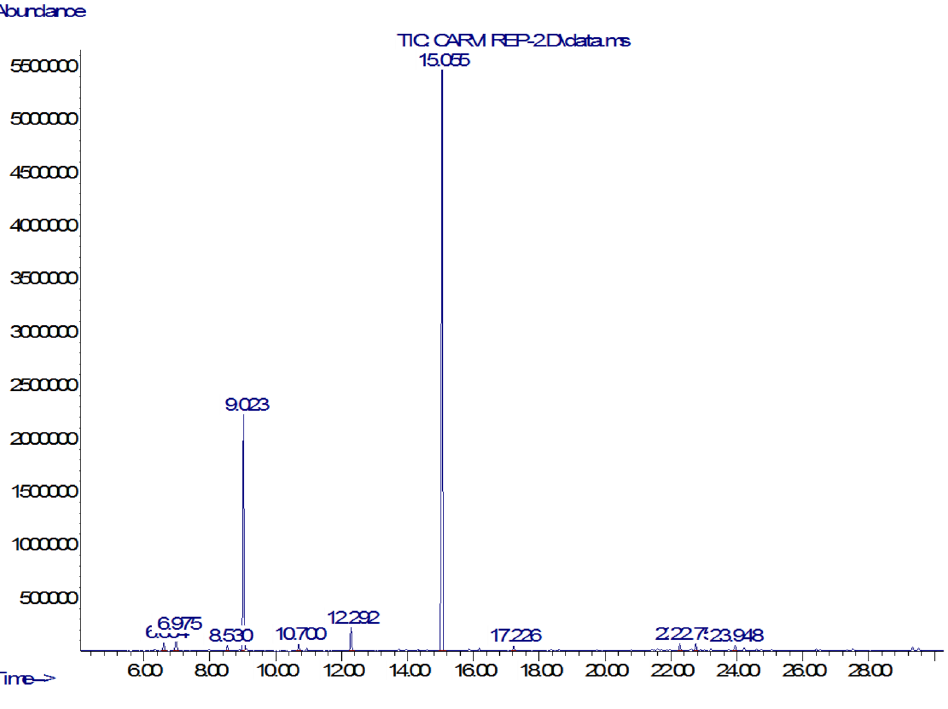
Figure 1. GC–MS spectra of